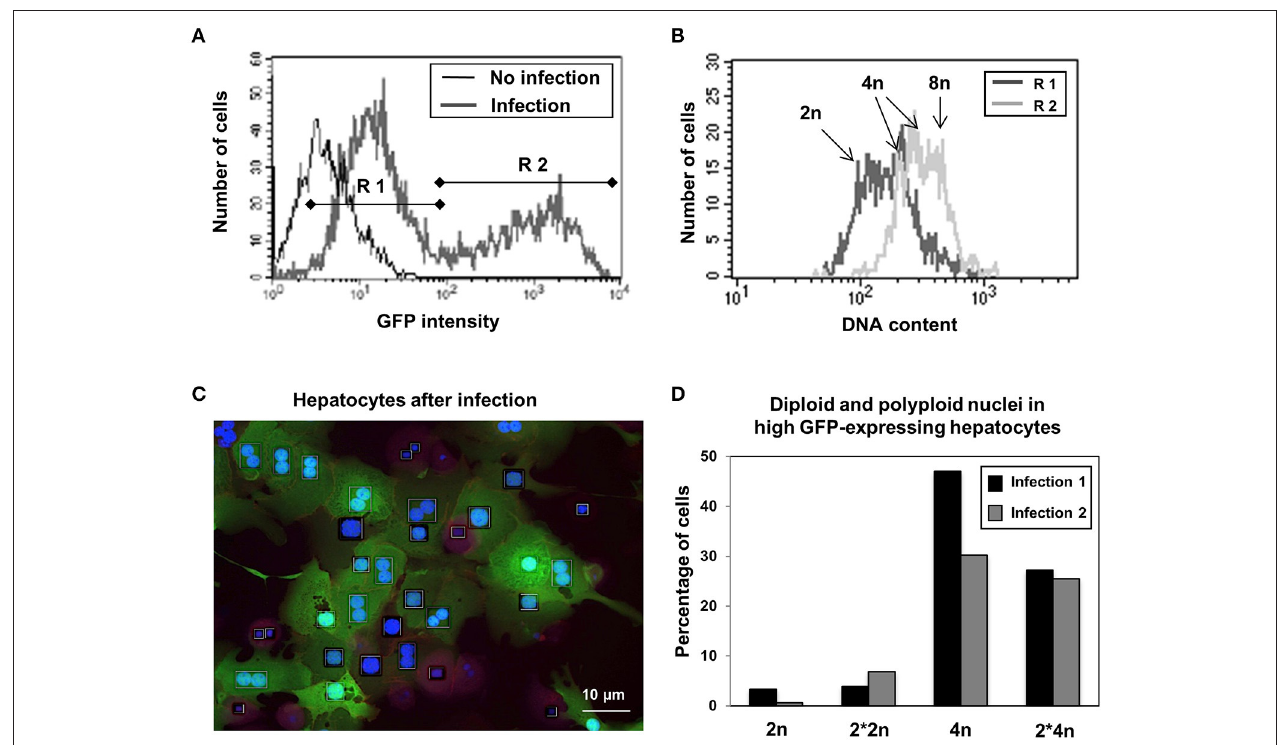
FIGURE 2 | Hepatocytes containing polyploid nuclei have higher basal metabolism as indicated by Adenoviral protein expression. (A) Two cell populations could be detected based on differing levels of expression of GFP under the CMV promoter 24h after adenoviral infection by flow cytometry. (B) Correlation between DNA amount and protein expression in low (R1) and high (R2) GFP expressing hepatocytes as seen by flow cytometry. (C) Representative microscopy image of GFP expressing hepatocytes after adenoviral infection after staining with DAPI. (D) The majority of the high GFP producing hepatocytes have polyploid nuclei, independent of the number of nuclei per cell. Percentage of diploid (2n) and polyploid (4n) nuclei containing cells in high GFP expressing hepatocytes in two independent cell preparations as analyzed by